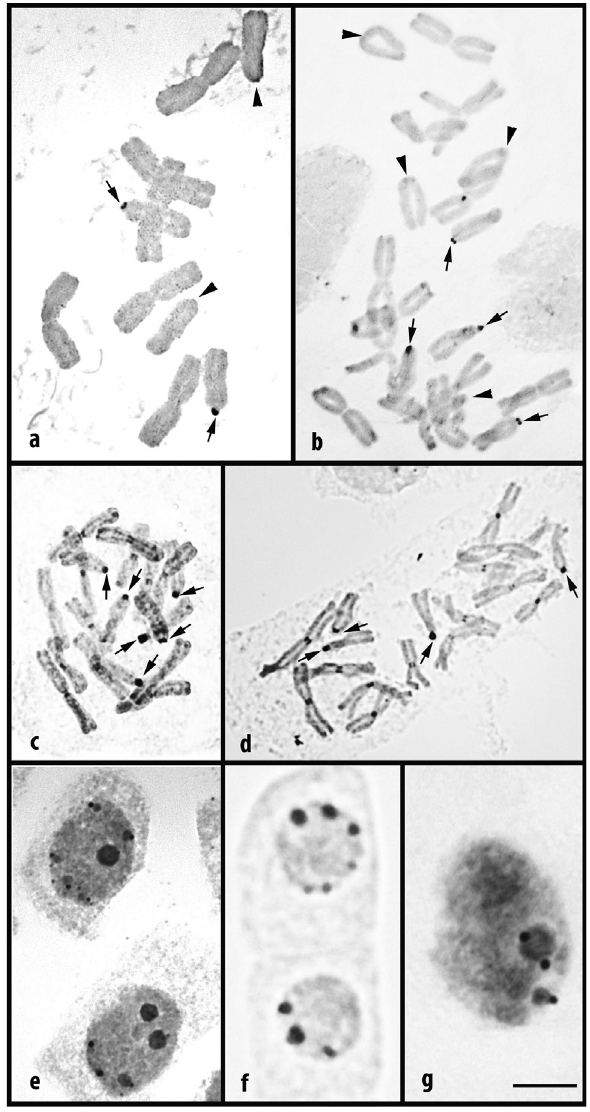
Figure3 -NORsandnucleoliinsomespeciesof Nothoscordum .Silverni- trate impregnation was done directly on slides (a, b) or on root tips (c-g). Metaphases of N. pulchellum 2 n = 10 (a); N. pulchellum 2 n = 20 (b); N. gracile 2 n = 19 (c); N. gracile 2 n = 18 (d). Nuclei of N. marchesii (e) and N. felipponei (f) with several nucleoli. Nucleus of N. pulchellum 2 n = 10 (g) with two nucleoli and deeply stained nucleolus associated chromatin. Observe non-specific staining of terminal regions, in b, and pericen- tromeric regions, in c and d. Arrows indicate NORs, arrowheads indicate acrocentric short arms without NORs. Bar corresponds to 10 (cid:2)